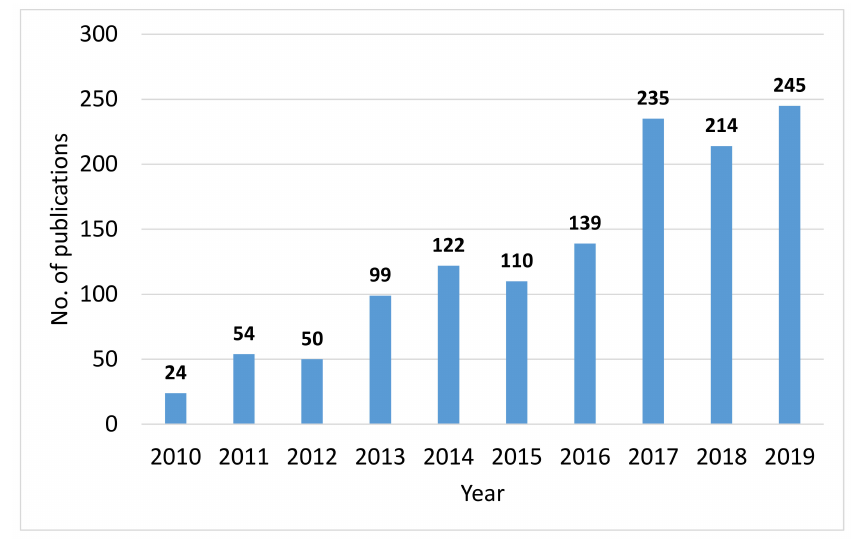
Figure 2. Number of carbon capture and utilization (CCU) focused articles according to year of